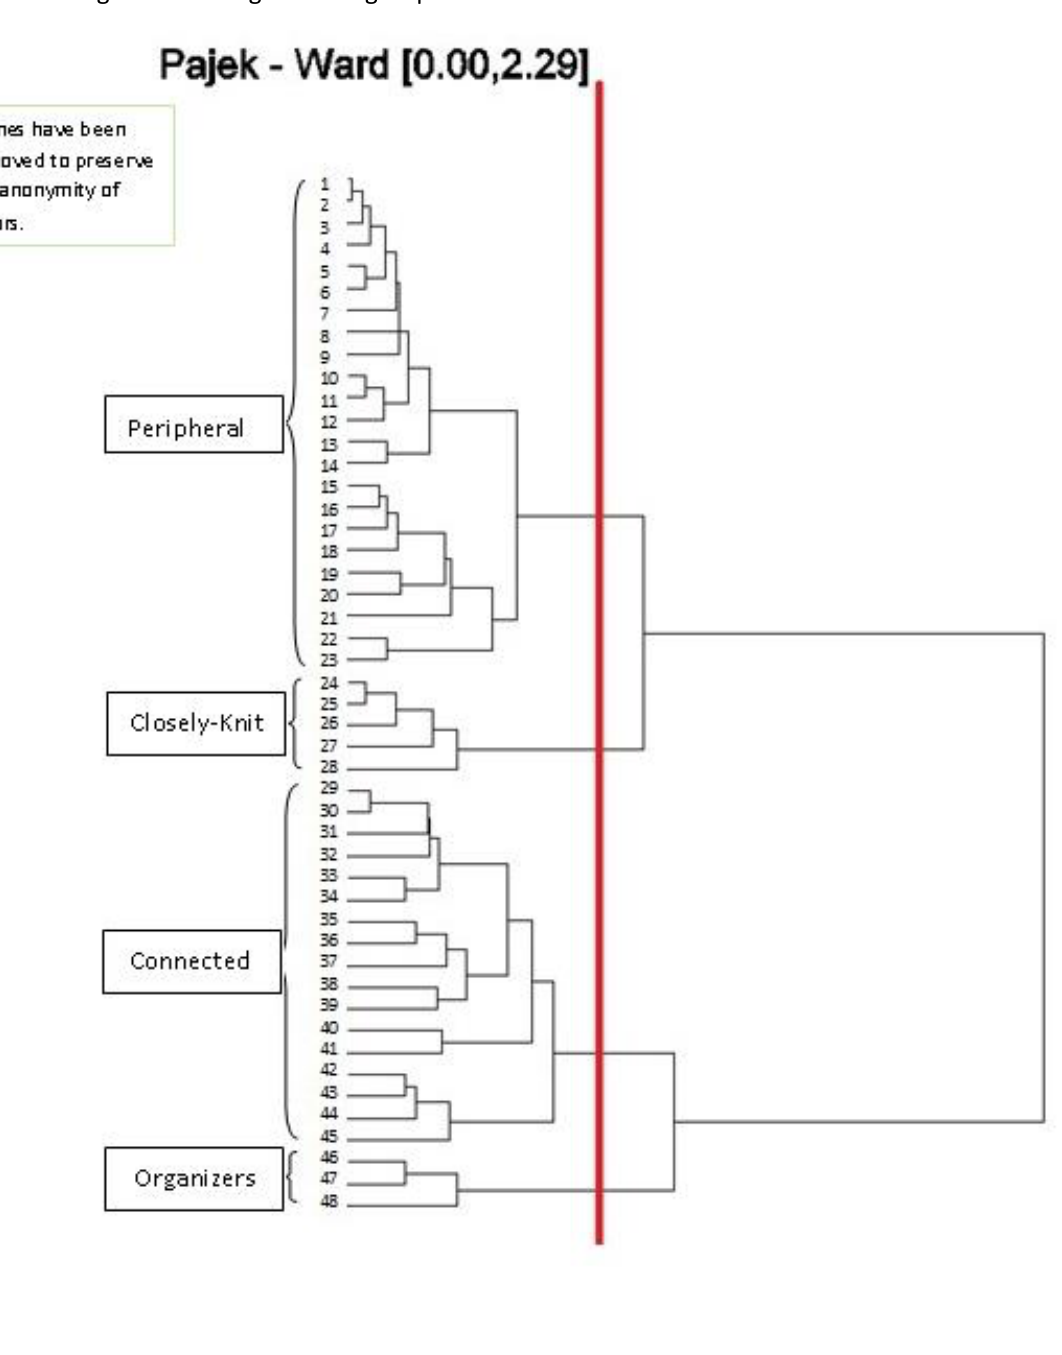
Fig. A1.1 . Dendrogram including the four groups of